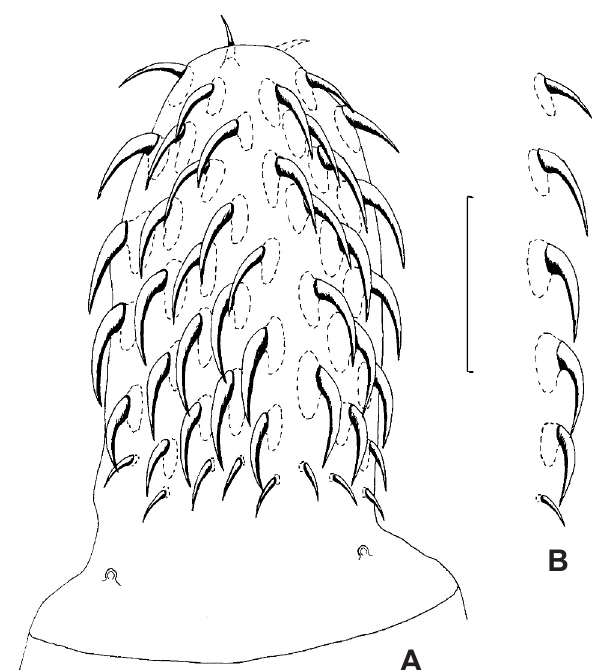
Fig. 2. – Proboscis (A) of male Solearhynchus kostylewi and a hooks row (B). Scale-bar: 100 µm.